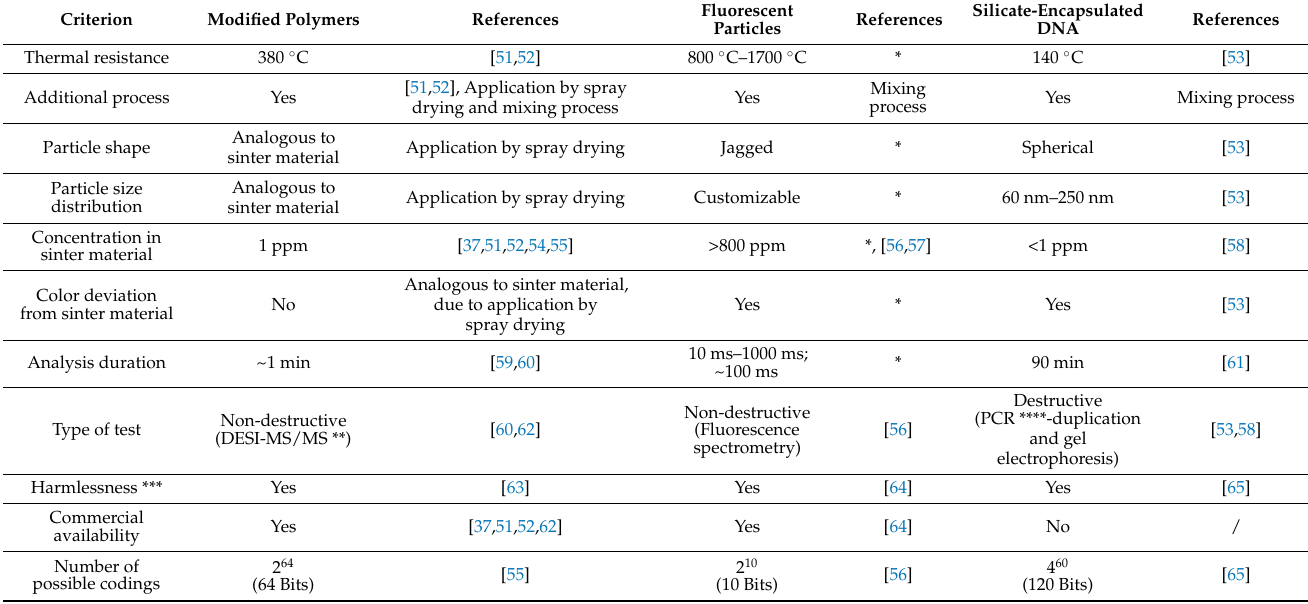
Table 1. Available properties of the investigated marking